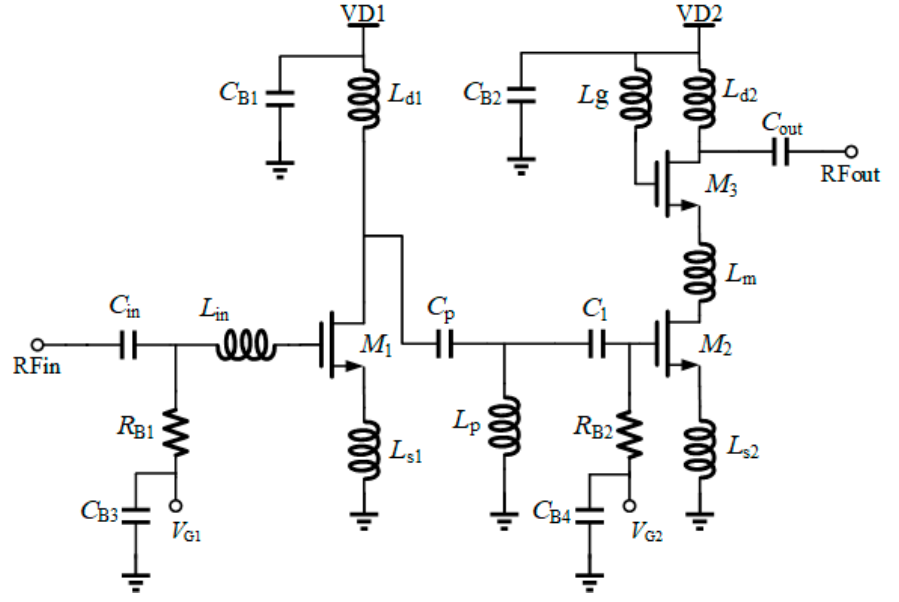
Figure 6. Schematic of two-stage single-end low-noise amplifier (LNA). Table 1. Elements values of proposed